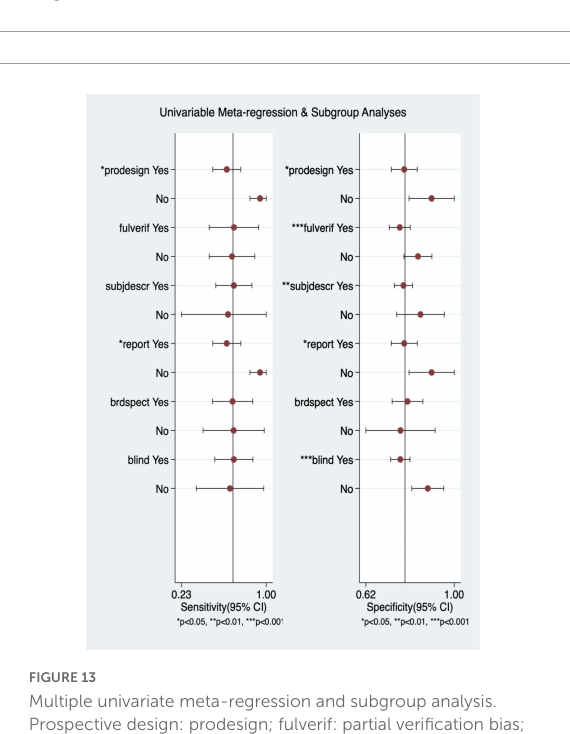
FIGURE12 Fagan diagram of left ventricular ejection fraction (LVEF) in the diagnosis of heart sound.